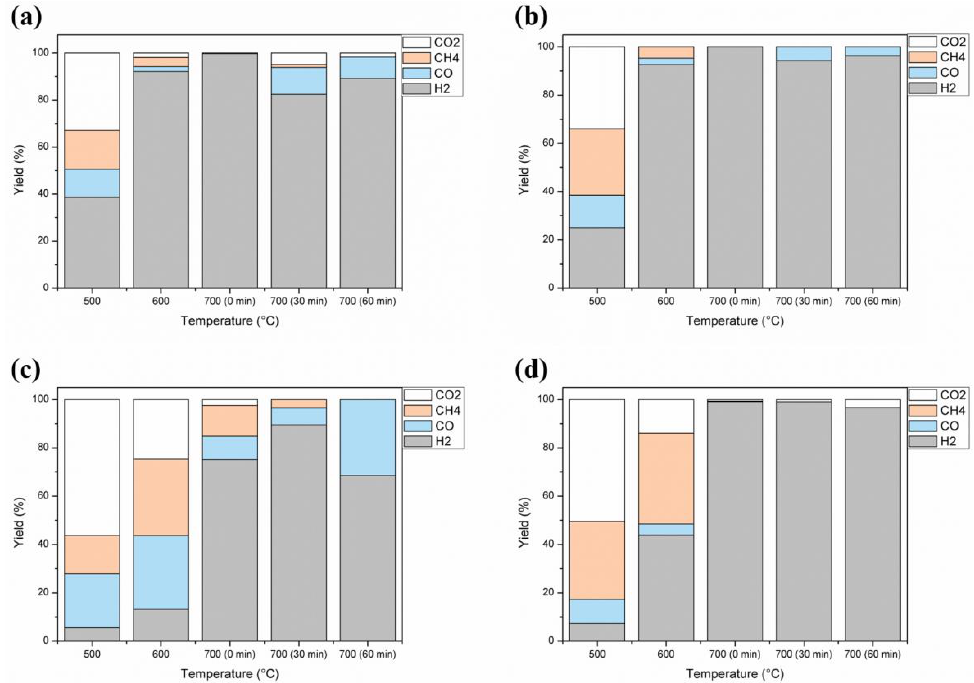
Figure 3. Effect of temperature on gas production during the pyrolysis of ( a ) FIB, ( b ) ALM, ( c ) END, and ( d ) DOA.